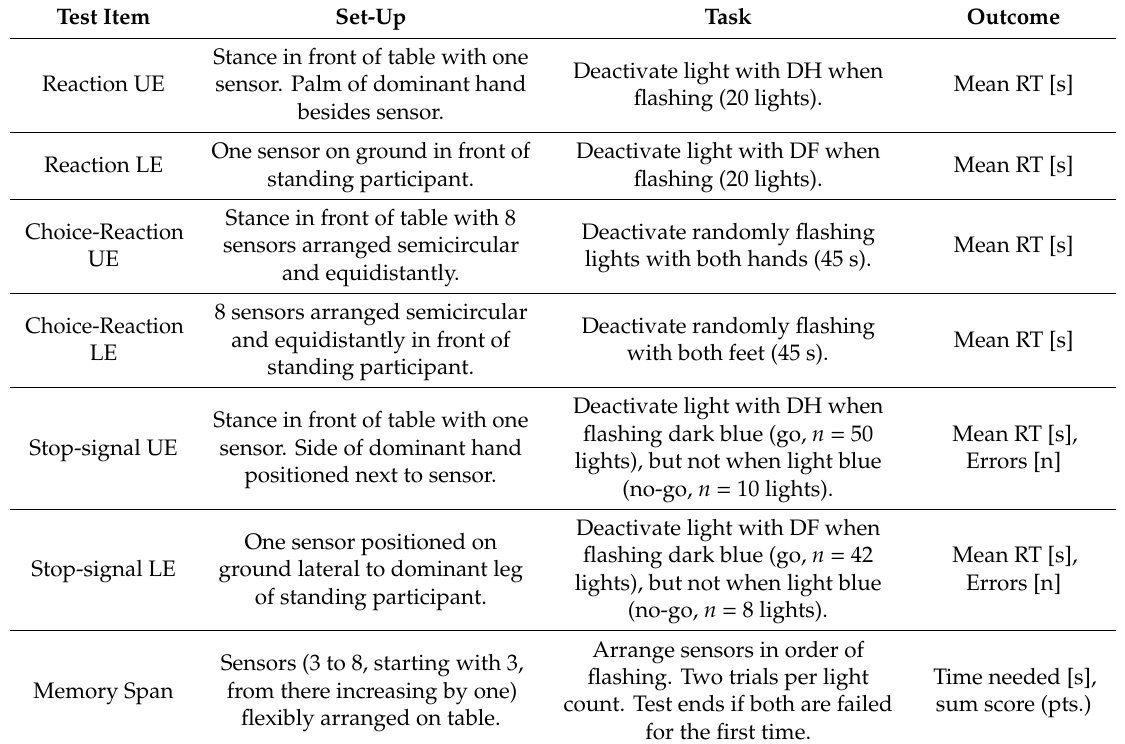
Table 1. Items of the motor-cognitive testing